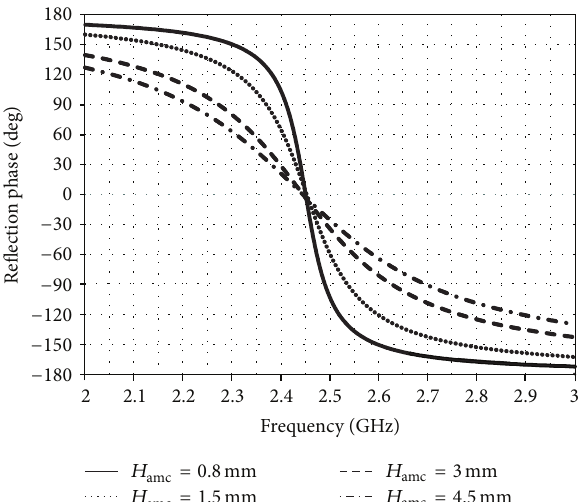
Figure 3: The reflection phase characteristics of the AMC structure with a square patch in a unit cell with different thickness of dielectric = 1.25 mm and the values of 𝑊 are 27.38mm, 25.6 mm, 21.25 mm, and 17.15mm, for 𝐻 substrate, where 𝑊 gap pa and 4.5mm,